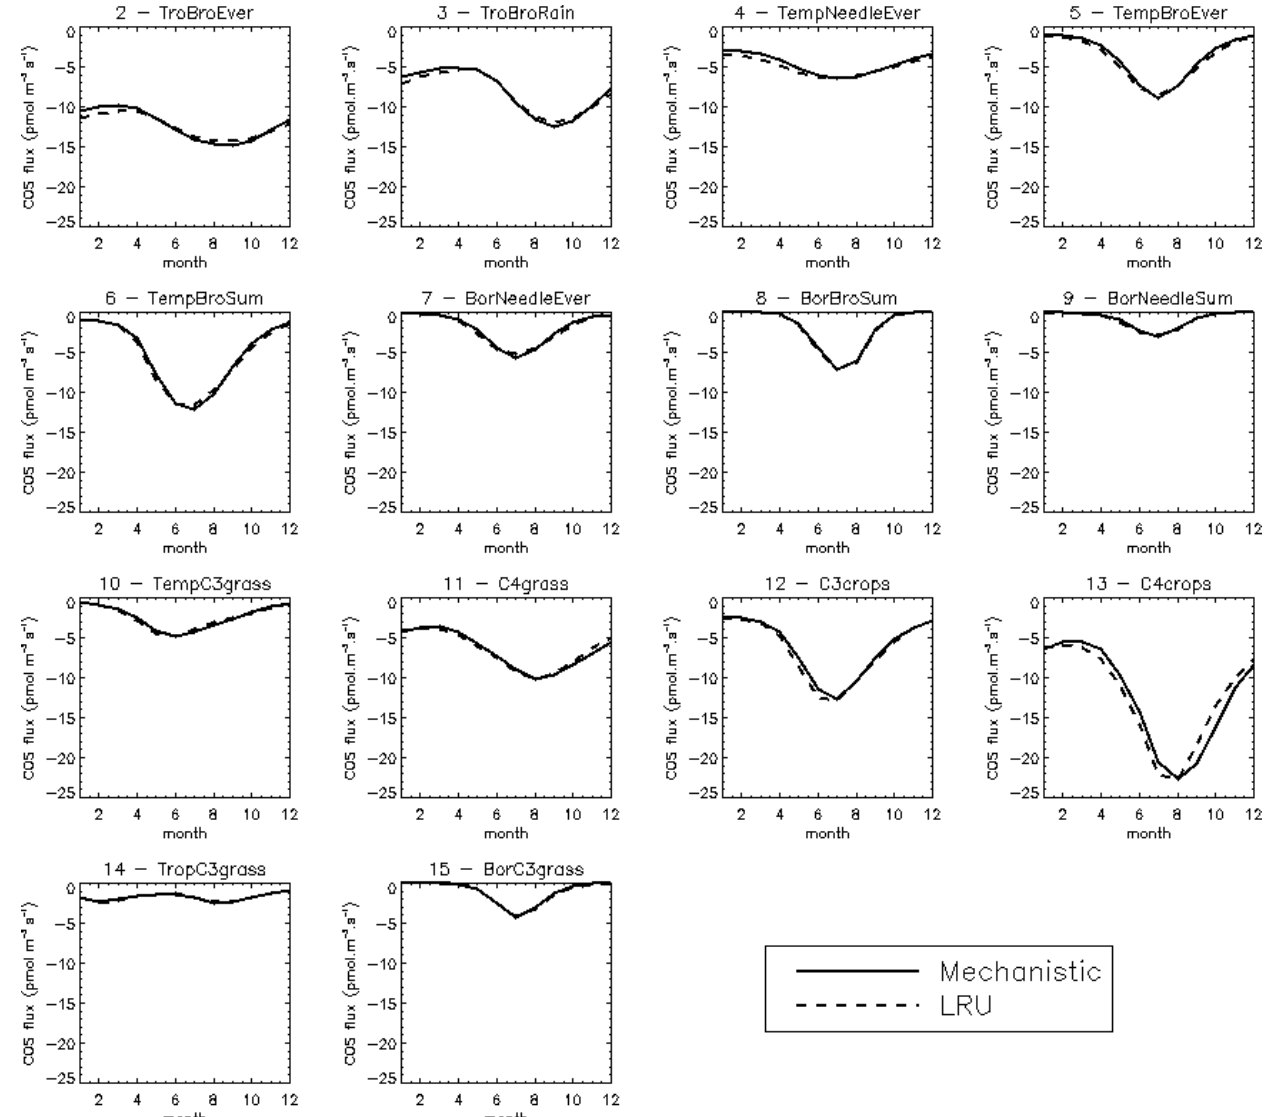
Figure C3. Mean seasonal cycle (monthly means) of COS for each PFT over the Northern Hemisphere for the 2000–2009 period. The solid line represents the mechanistic model, while the dashed line represents the optimal LRU